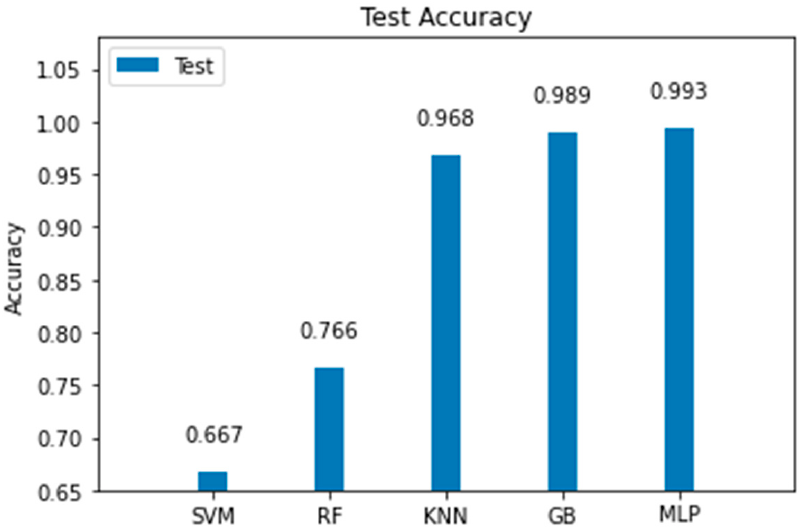
Figure 15. Comparison of the accuracy achieved for the test data by the MLP model against other machine learning models.